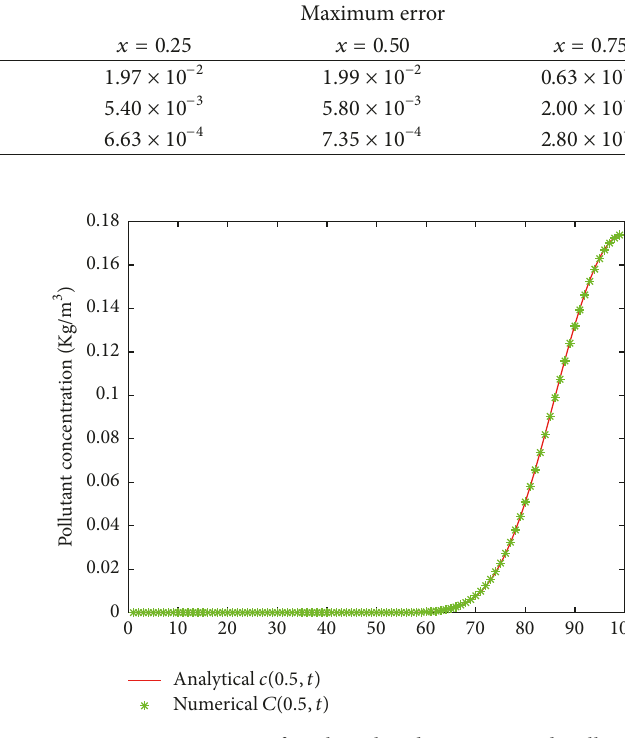
Figure 5: Comparison of analytical and approximated pollutant concentrations 𝑐(0.5, 𝑡) (kg/m 3 ) (Δ𝑥 = 0.0125 , Δ𝑡 = 0.0100 , Pe = 1.25) .